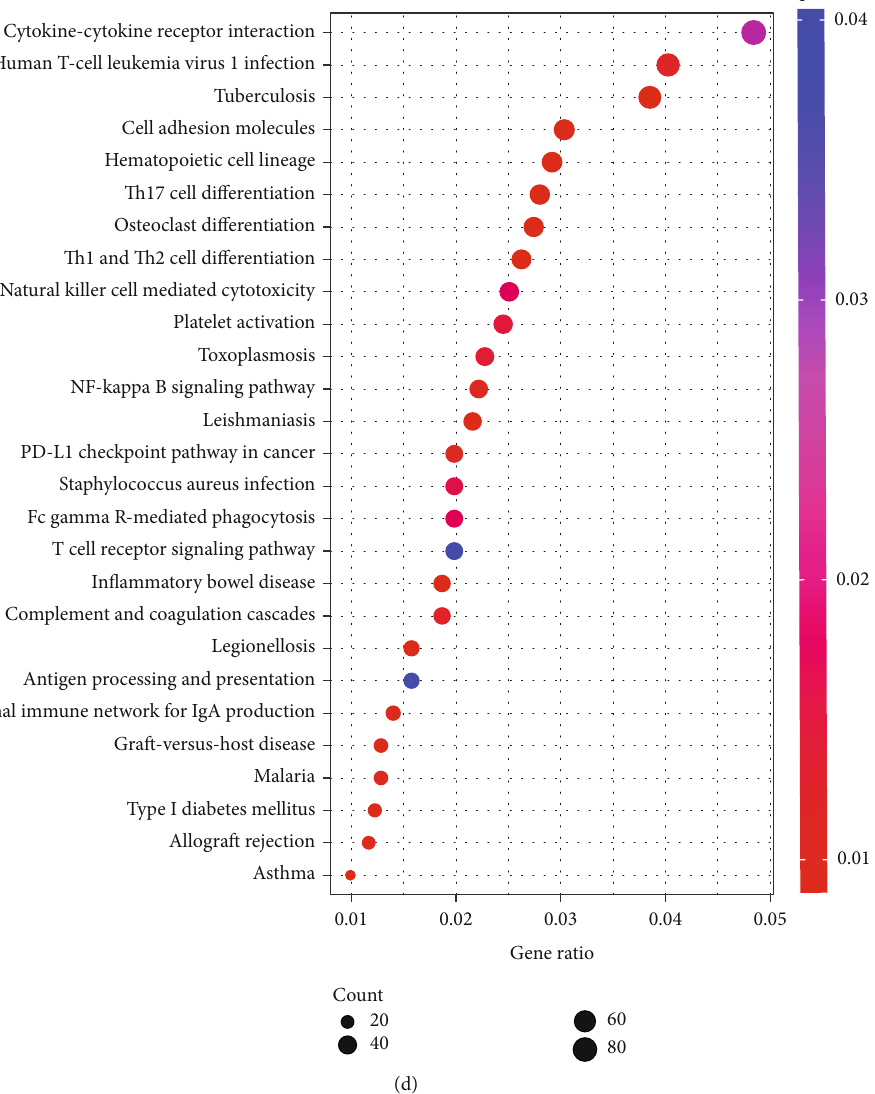
Figure 2: Functional enrichment analyses to identify potential biological processes via disease ontology and gene set enrichment analysis. (a) Disease ontology enrichment analysis of di ff erentially expressed genes between KD and normal samples. (b) Enrichment analyses via gene set enrichment analysis. (c) Bubble plot of DEGs in KEGG. (d) GO of